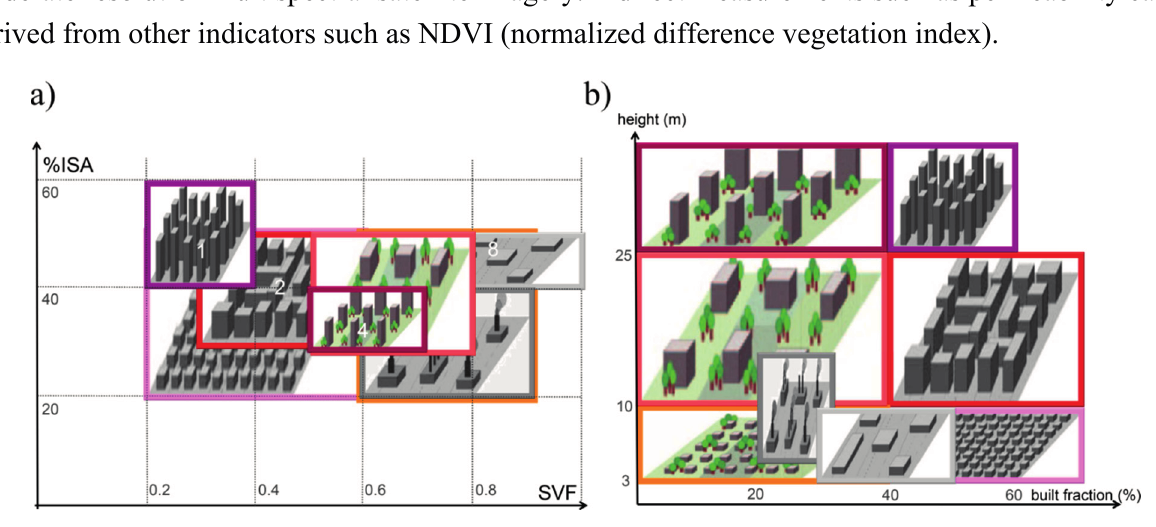
Figure 2. Potential separation of built LCZ classes according to selected feature pairs. ( a ) Sky view factor (SVF) and percentage of impervious surface area (%ISA); ( b ) built fraction and building height.